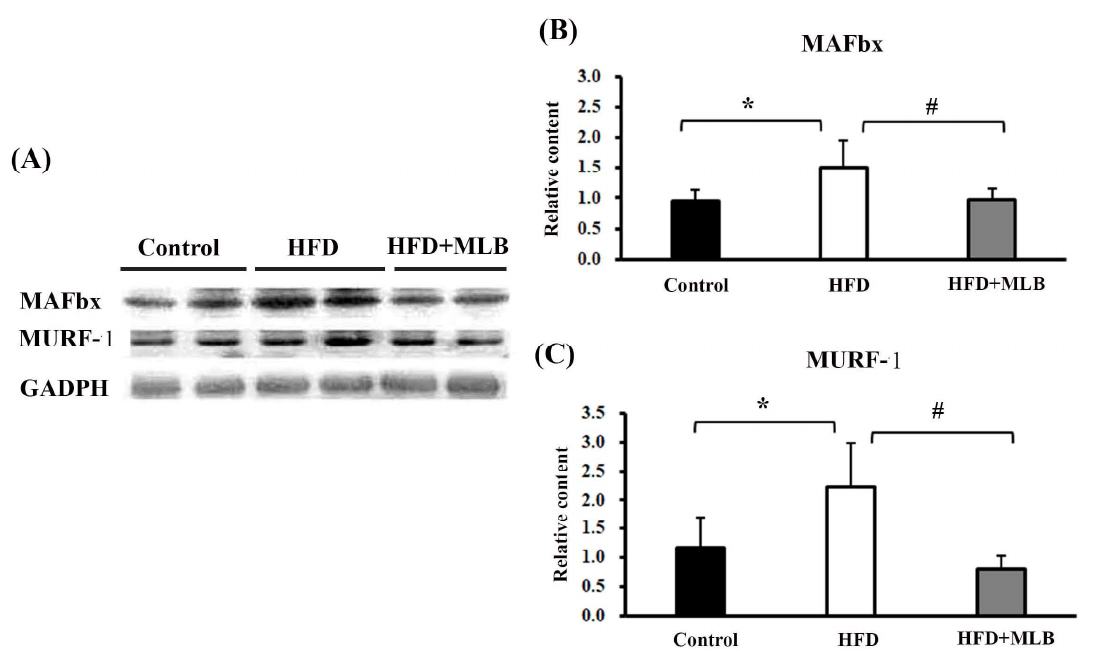
Figure 5. MLB supplementation attenuated HFD-induced muscle atrophy through inhibiting protein degradation in skeletal muscles. Proteins were isolated from skeletal muscles and subjected to a Western blot with antibodies against MAFbx, MURF-1, and GAPDH. Two representative samples from each group are presented ( A ), and the quantitative data are depicted ( B , C ). Values are expressed as the mean ± SD. * p < 0.05 vs. control group. # p < 0.05 vs. HFD group. n =